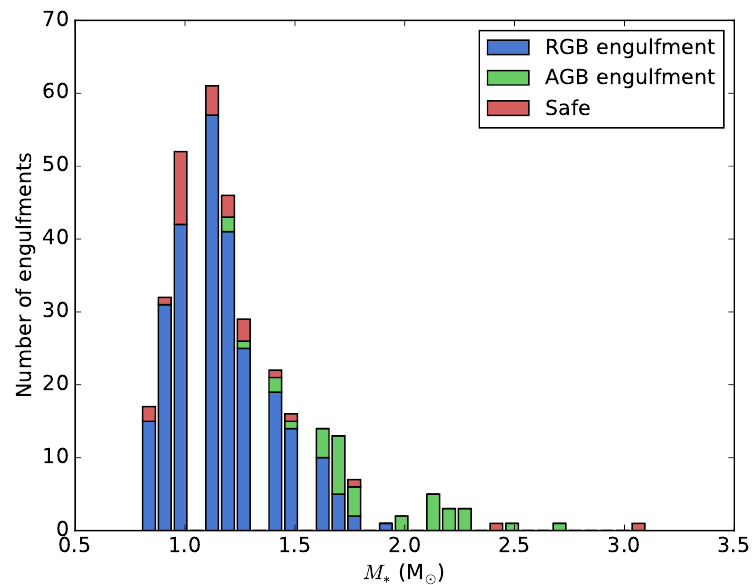
Figure 1. Histogram displaying the resulting number of planet engulfment of the known exoplanets as a function of stellar mass. In this model, each star–planet system is evolved using stellar models with the measured metallicity of the host star.